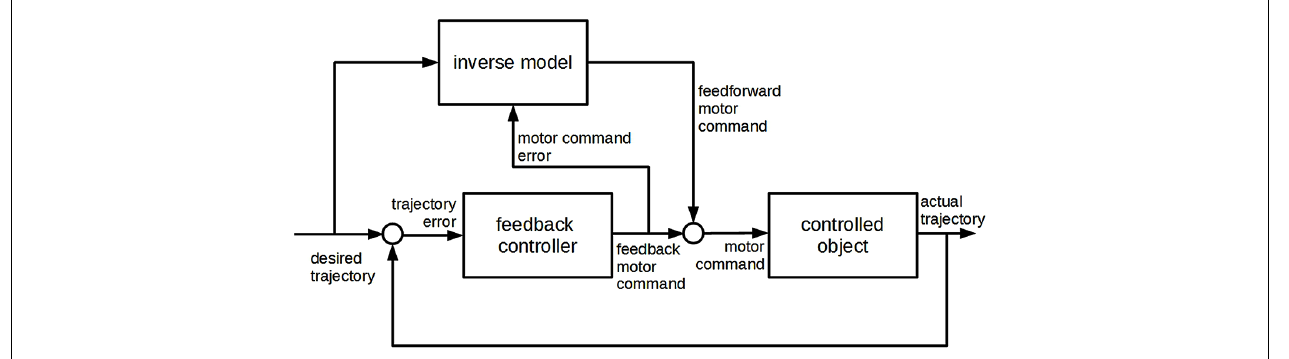
FIGURE 1 |A box-and-arrow model of motor control (adapted fromWolpert etal., 1998).